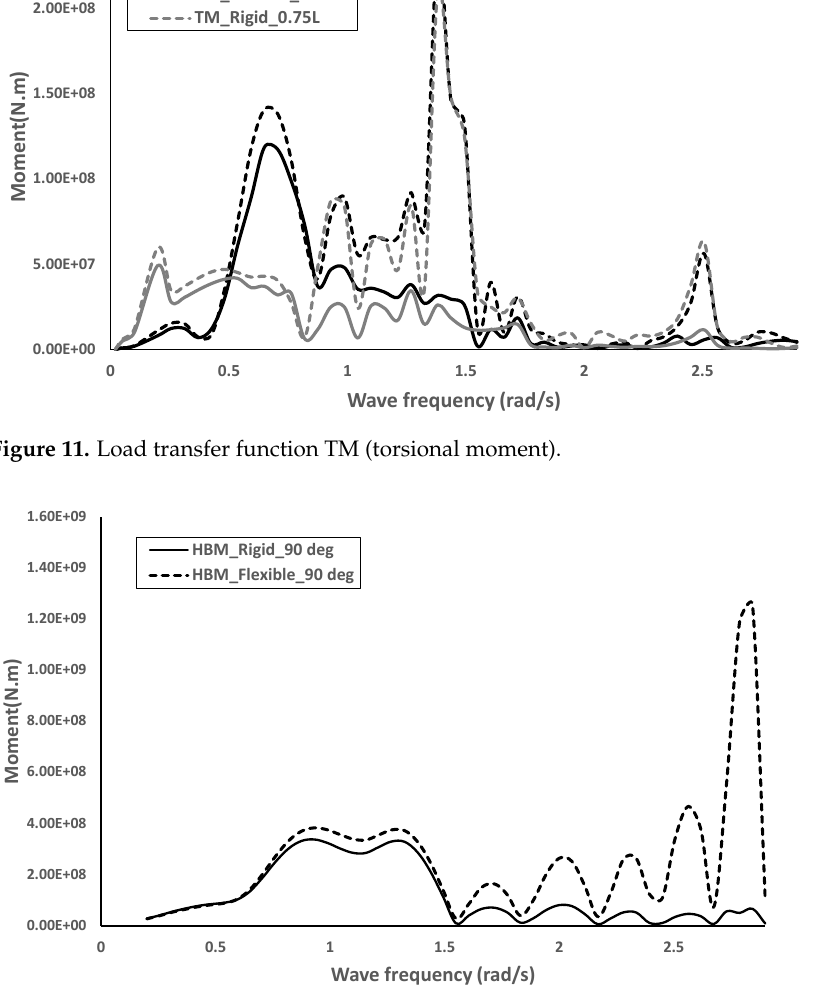
Figure 12. Load transfer function HBM (horizontal bending moment).